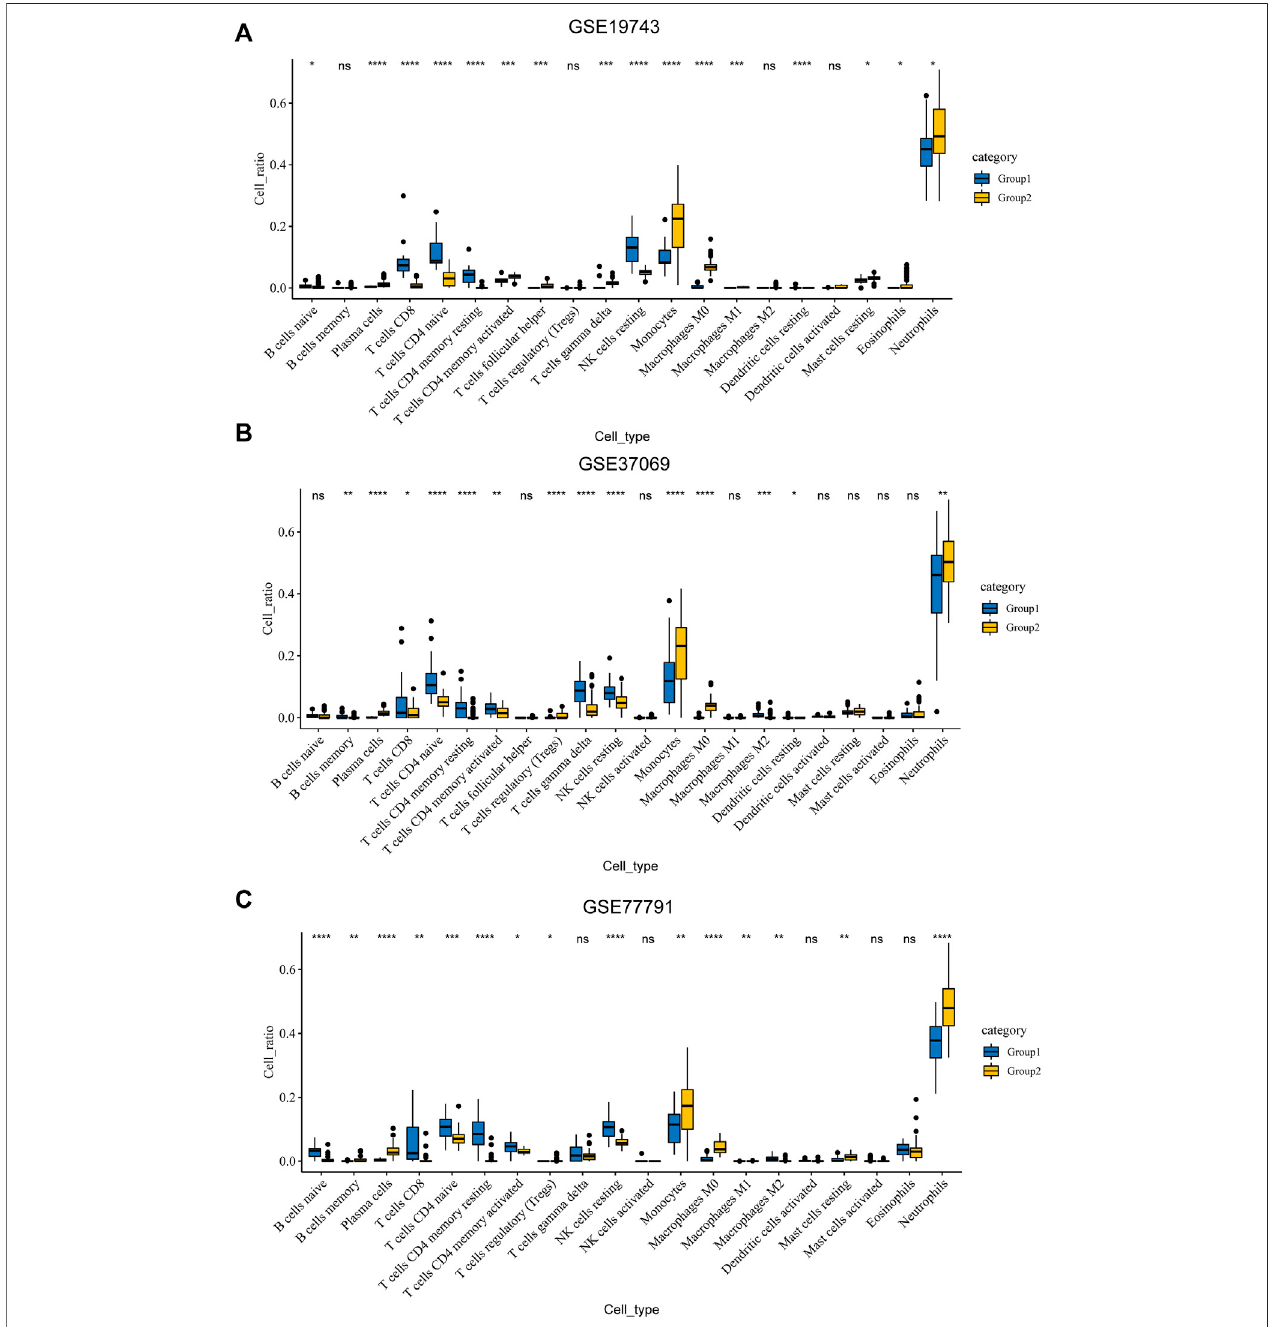
FIGURE 3 | Results of CIBERSORT. (A) Different ratios of the 22 immune cells between severe burns and controls in GSE19743. (B) Different ratios of the 22 immune cells between severe burns and controls in GSE37069. (C) Different ratios of the 22 immune cells between severe burns and controls in GSE77791.